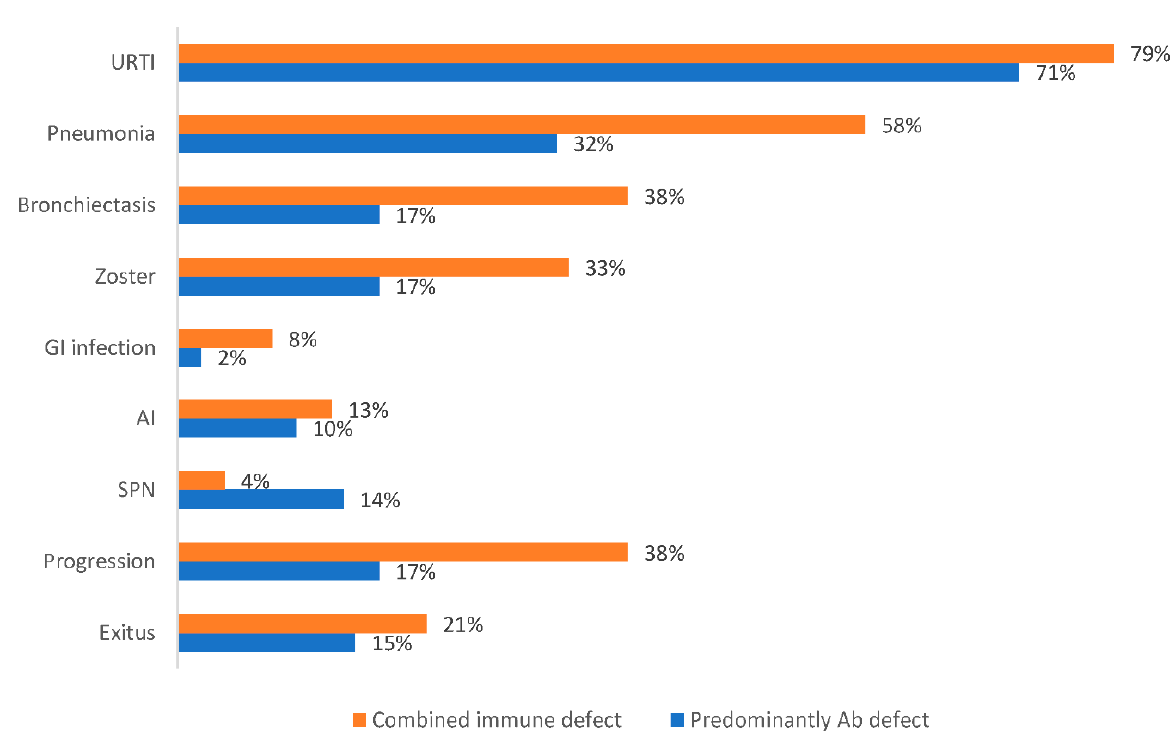
Figure 1. Proportion of clinical manifestations according to the immune defect phenotype.